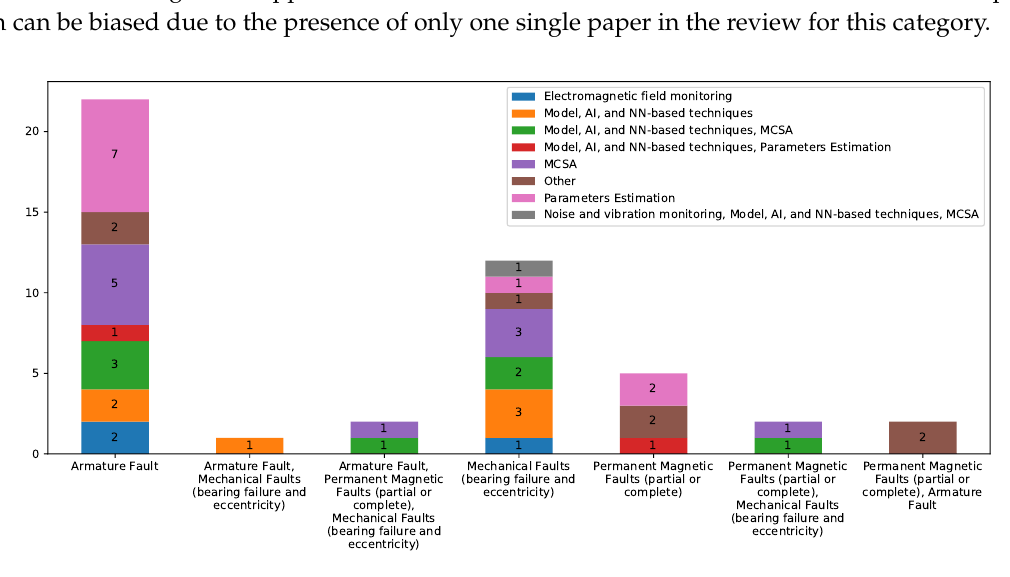
Figure 7. Distribution of the papers according the type of failure and the used